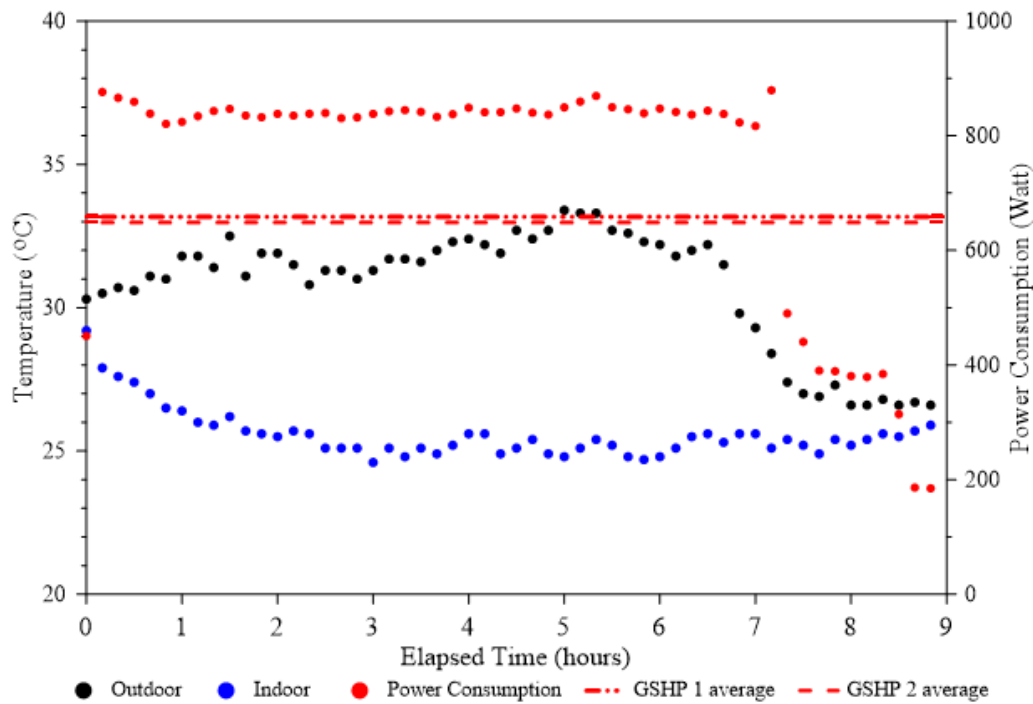
Figure 16. One-day operational data of the ASHP (June 27).